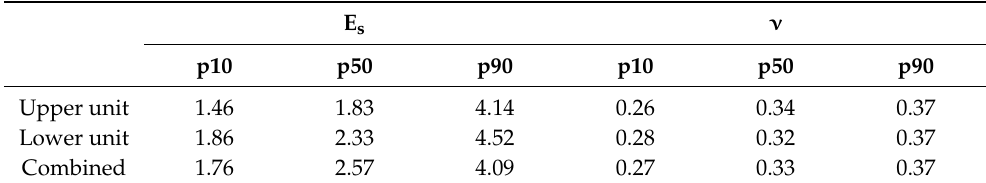
Table 2. Upper and lower limits of Young’s modulus and Poisson’s ratio of Upper Jurassic caprocks in NCS. E